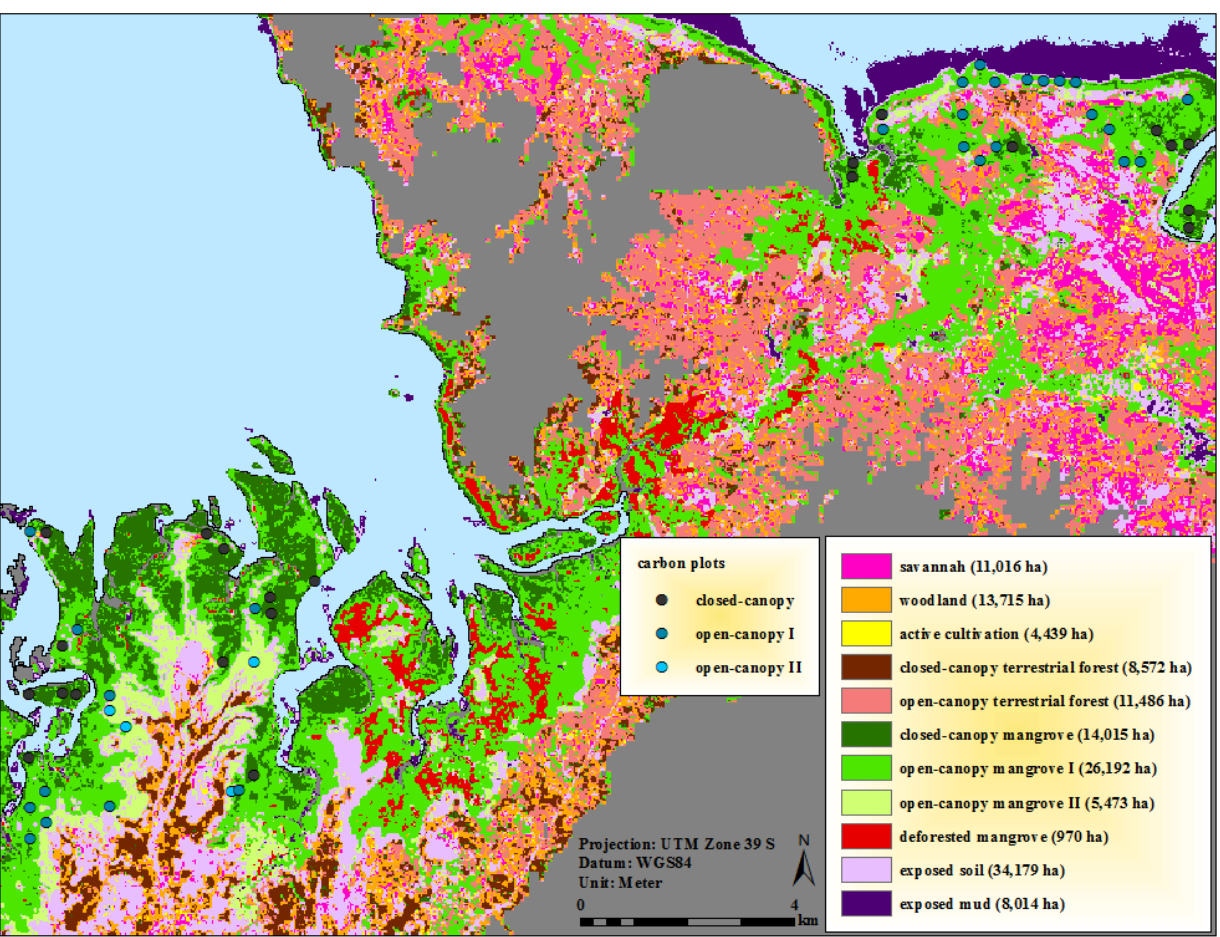
Figure 6. The location of C plots within classified mangrove